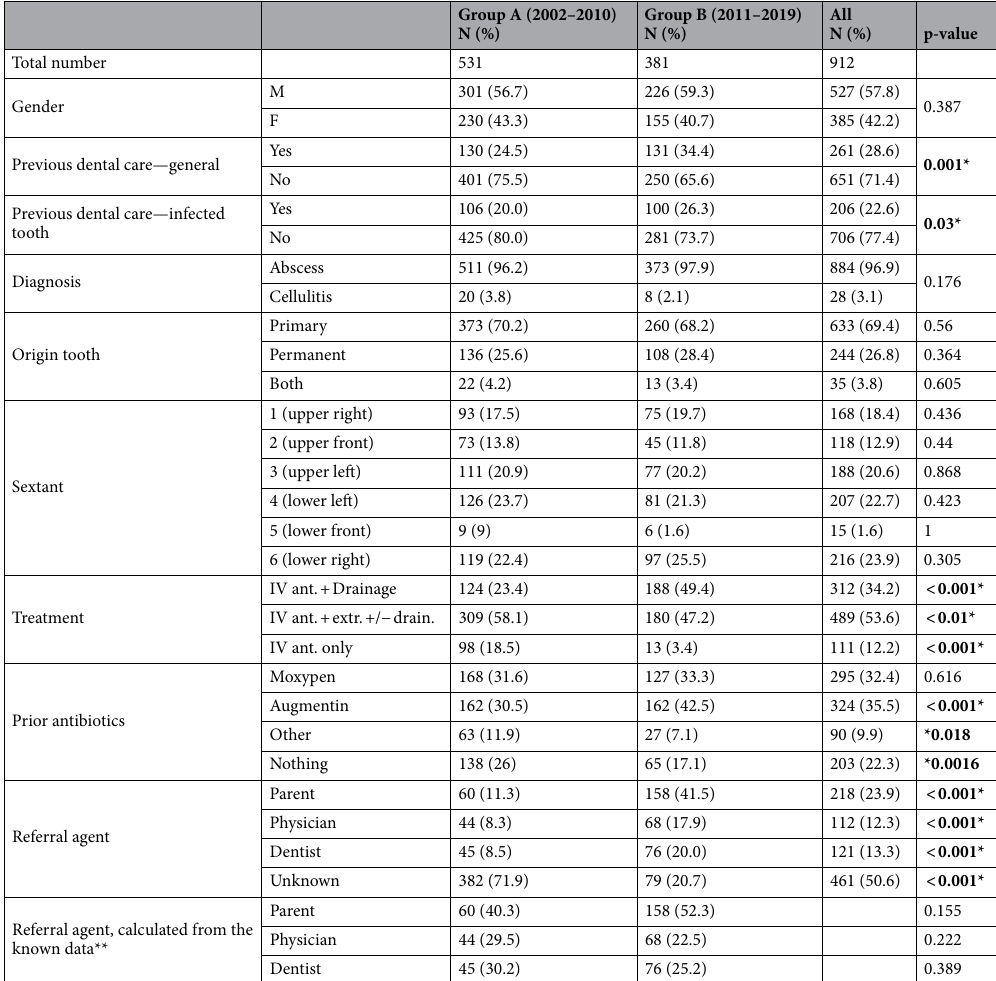
Table 1. Patient and hospitalization characteristics before and after (group A and B, respectively) inclusion of pediatric dental care in Israel’s National Health Insurance Law. ant. Antibiotics, extr. Extraction, drain.